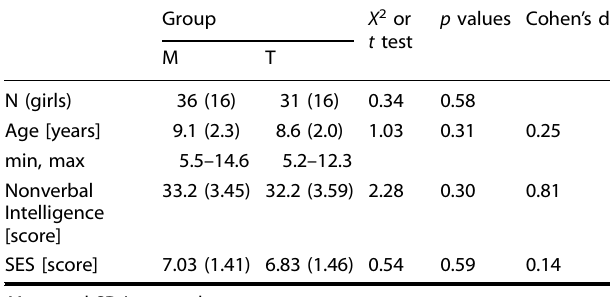
Table 1. Demographic and nonverbal intelligence data for the Montessori — (M) and traditionally — (T) schooled children.